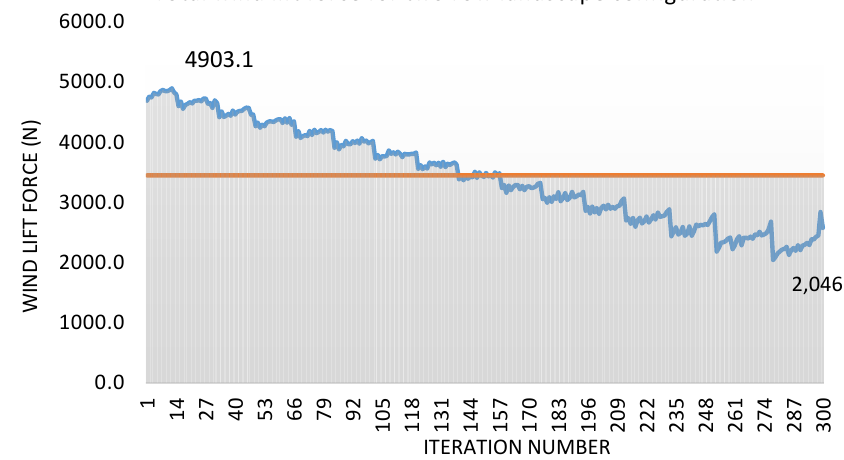
Figure 8. Convergence of lift force values (Objective Function) for case II.